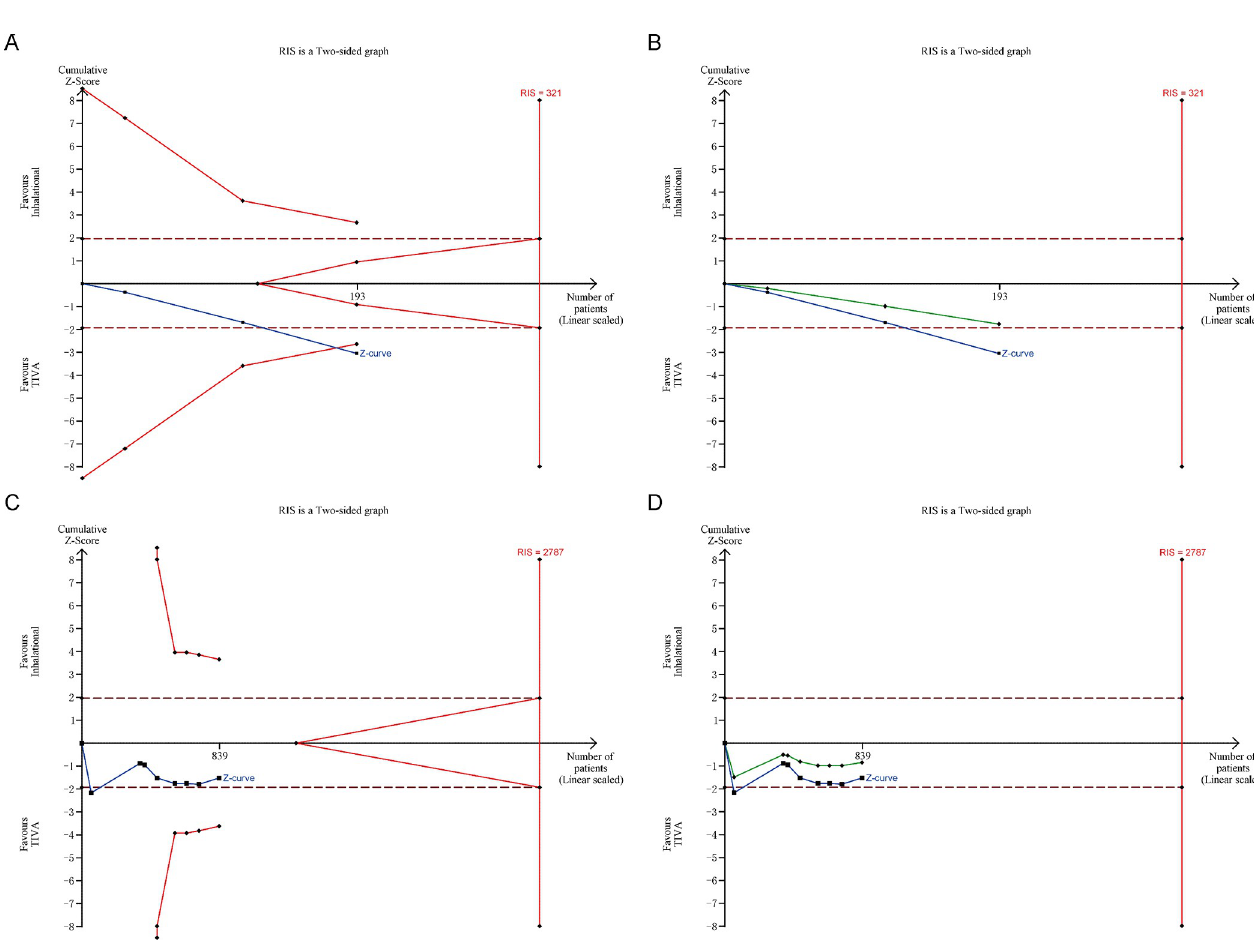
Fig 5. Forest plots for physical independence (A) and pain (B) with TIVA versus inhalational maintenance. CI, confidence interval; df, degrees of freedom; I 2 , heterogeneity index; IV, inverse variance; SD, standard deviation; QoR-40, Quality of Recovery-40 questionnaire; TIVA, total intravenous